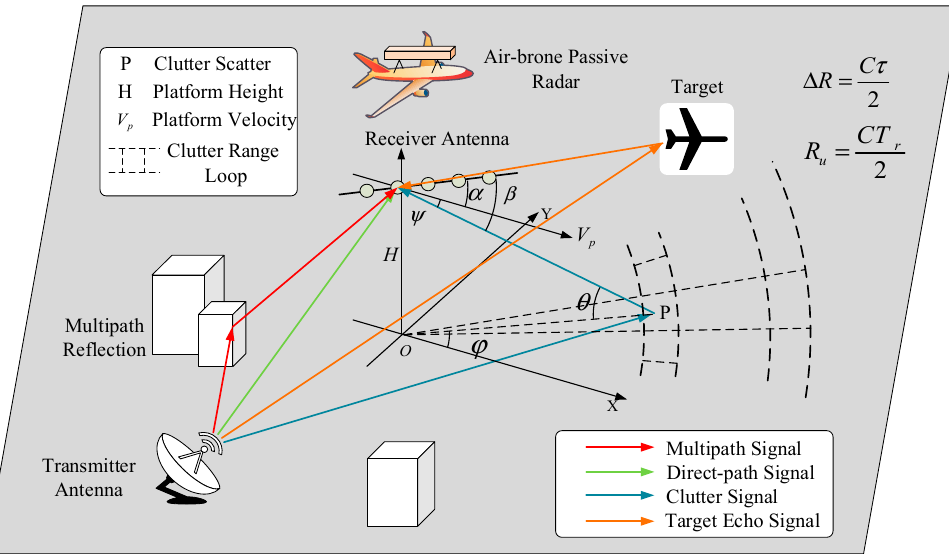
Figure 1. Structure of airborne passive bistatic radar (PBR) system.